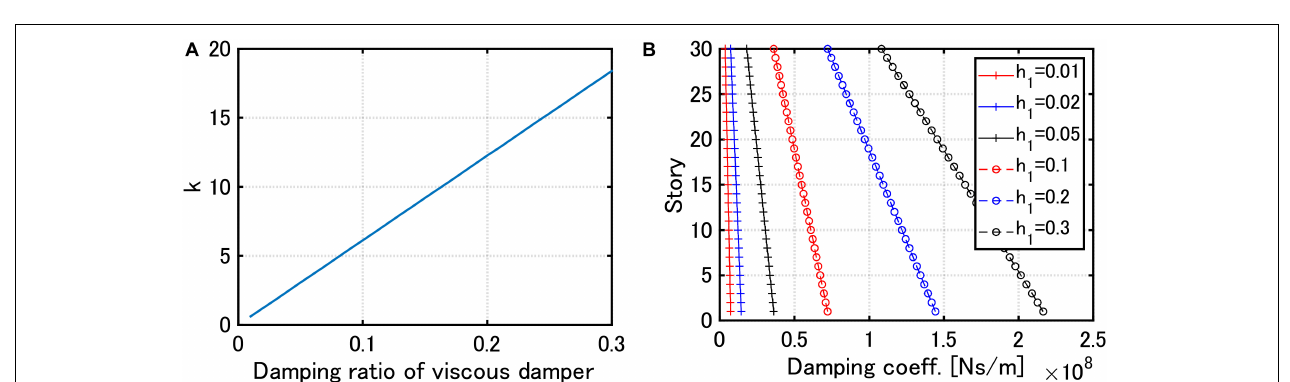
FIGURE 6 | Damper properties, (A) Stiffness ratio k of DSA in DHD to main frame with respect to damping ratio h 1 of viscous damper in HVH (using Eq. (18) for V = 1.0(m/s)), (B) Damping coefficient c i of viscous dampers in HVH for several damping ratios.